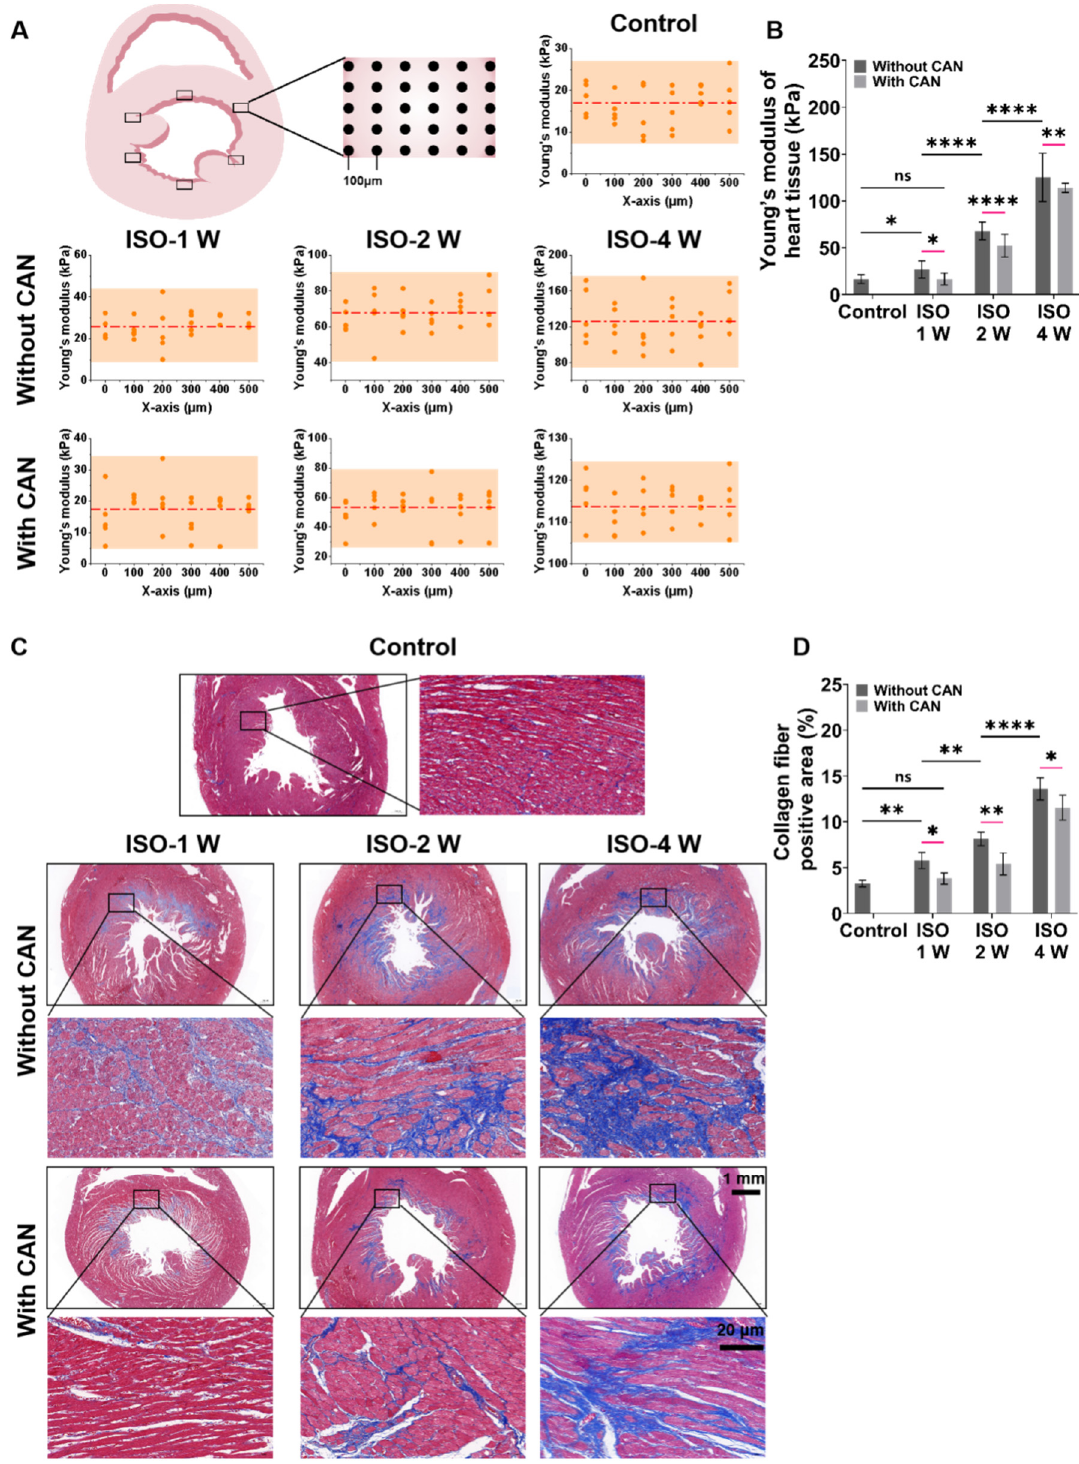
Figure 1. Characterization results of myocardial tissue stiffness and collagen deposition in myocardial fibrosis rats without and with CAN treatment. ( A ) Stiffness diagrams of tissue samples were obtained based on their Young’s moduli measured by nanoindentation instrument. ( B ) Statistical histograms of tissue stiffness of fibrotic myocardium ( n = 5). ( C ) Representative Masson’s trichrome staining images of fibrotic myocardium without and with CAN treatment. ( D ) Statistical histograms of collagen fiber-positive area (%) ( n = 5). Data are shown as means ± SEM. ns, no significant difference, * p < 0.05, ** p < 0.01 and **** p < 0.0001 determined by two-way ANOVA.